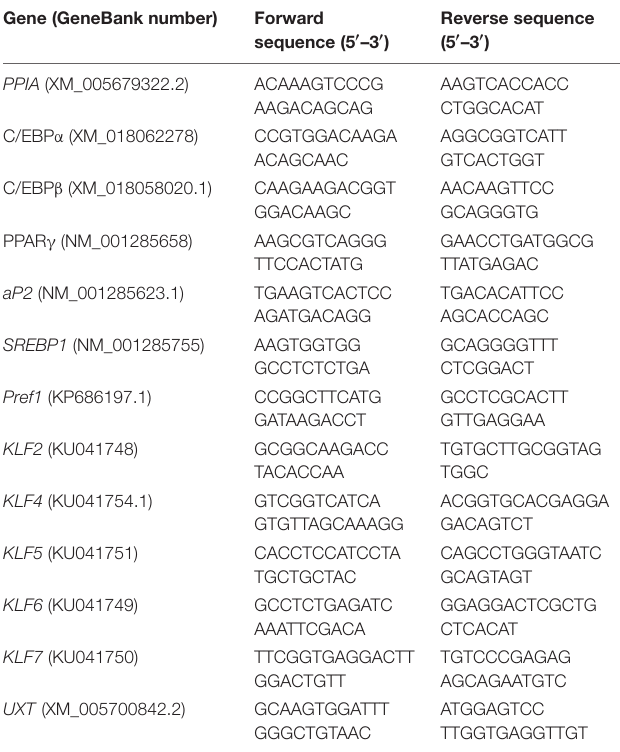
TABLE 1 | Primer information for quantitative real-time PCR (qPCR). Gene (GeneBank number) Forward sequence (5 (cid:48) –3 (cid:48)